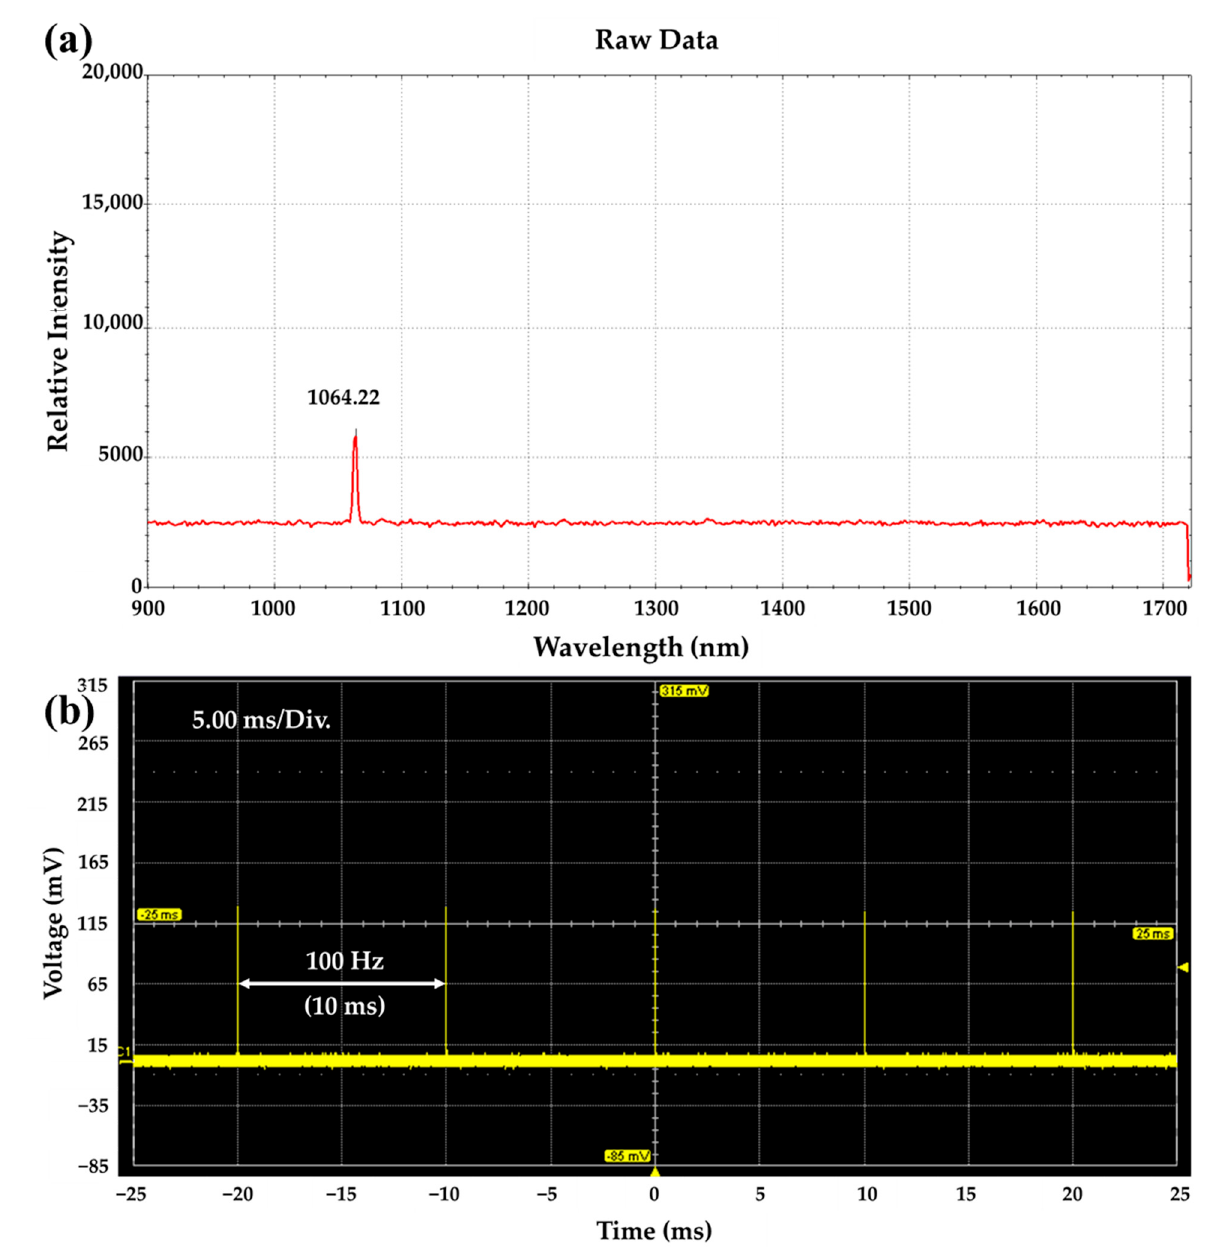
Figure 2. ( a ) Measured spectrum of the doubly Q-switched 1064 nm Nd:YAG laser, ( b ) pulse train of the AO Q-switched 1064 nm Nd:YAG laser.